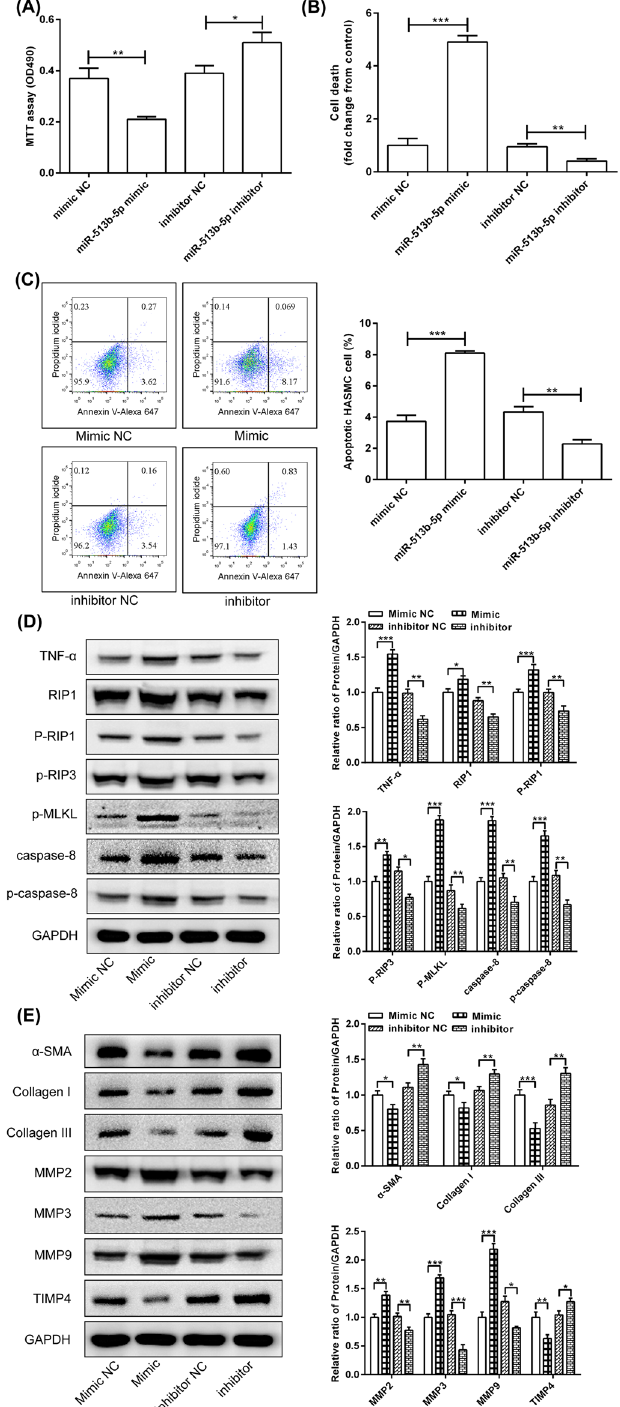
Figure 3. MiR-513b-5p regulated the viability of the HASMCs by the RIP1-RIP3-MLKL and MMP pathways. ( A ) MTT assay was used to analyse HASMC cell viability. ( B ) LDH release assay was used to detect cell death. ( C ) Flow cytometric analysis was performed to detect cell apoptosis. ( D ) Western blot was used to detect the expression of related proteins in the RIP1-RIP3-MLKL pathway. ( E ) Analyze the expression of related proteins in the MMP pathway. All data presented as the mean ± standard deviation, and three independent experiments were carried out. Compared with mimic NC or inhibitor NC group, * p < 0.05, ** p < 0.01, and *** p < 0.001. Student’s t test with two-sided was